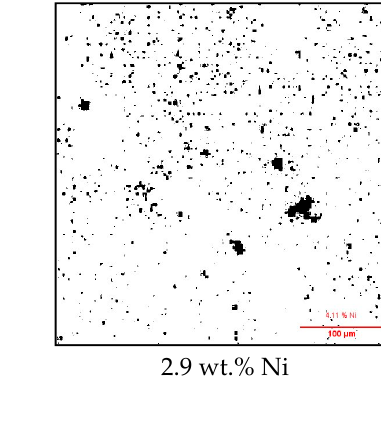
Figure 9. EDX test results on the surface of Cu CC after washing, melting, and battery testing.